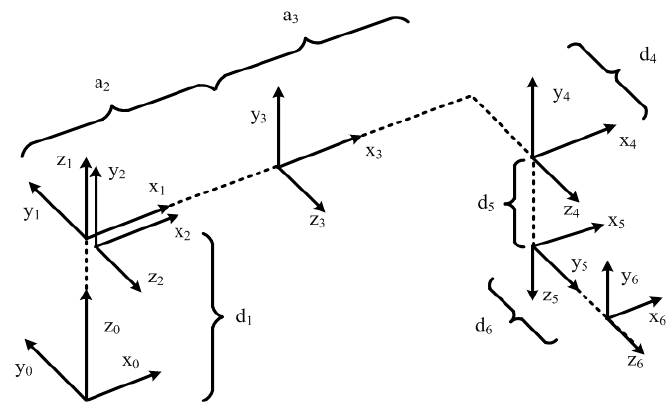
Figure 3. Schematic and frame assignment of UR3 ( θ i = 0 for 1 ≤ i ≤ 6).